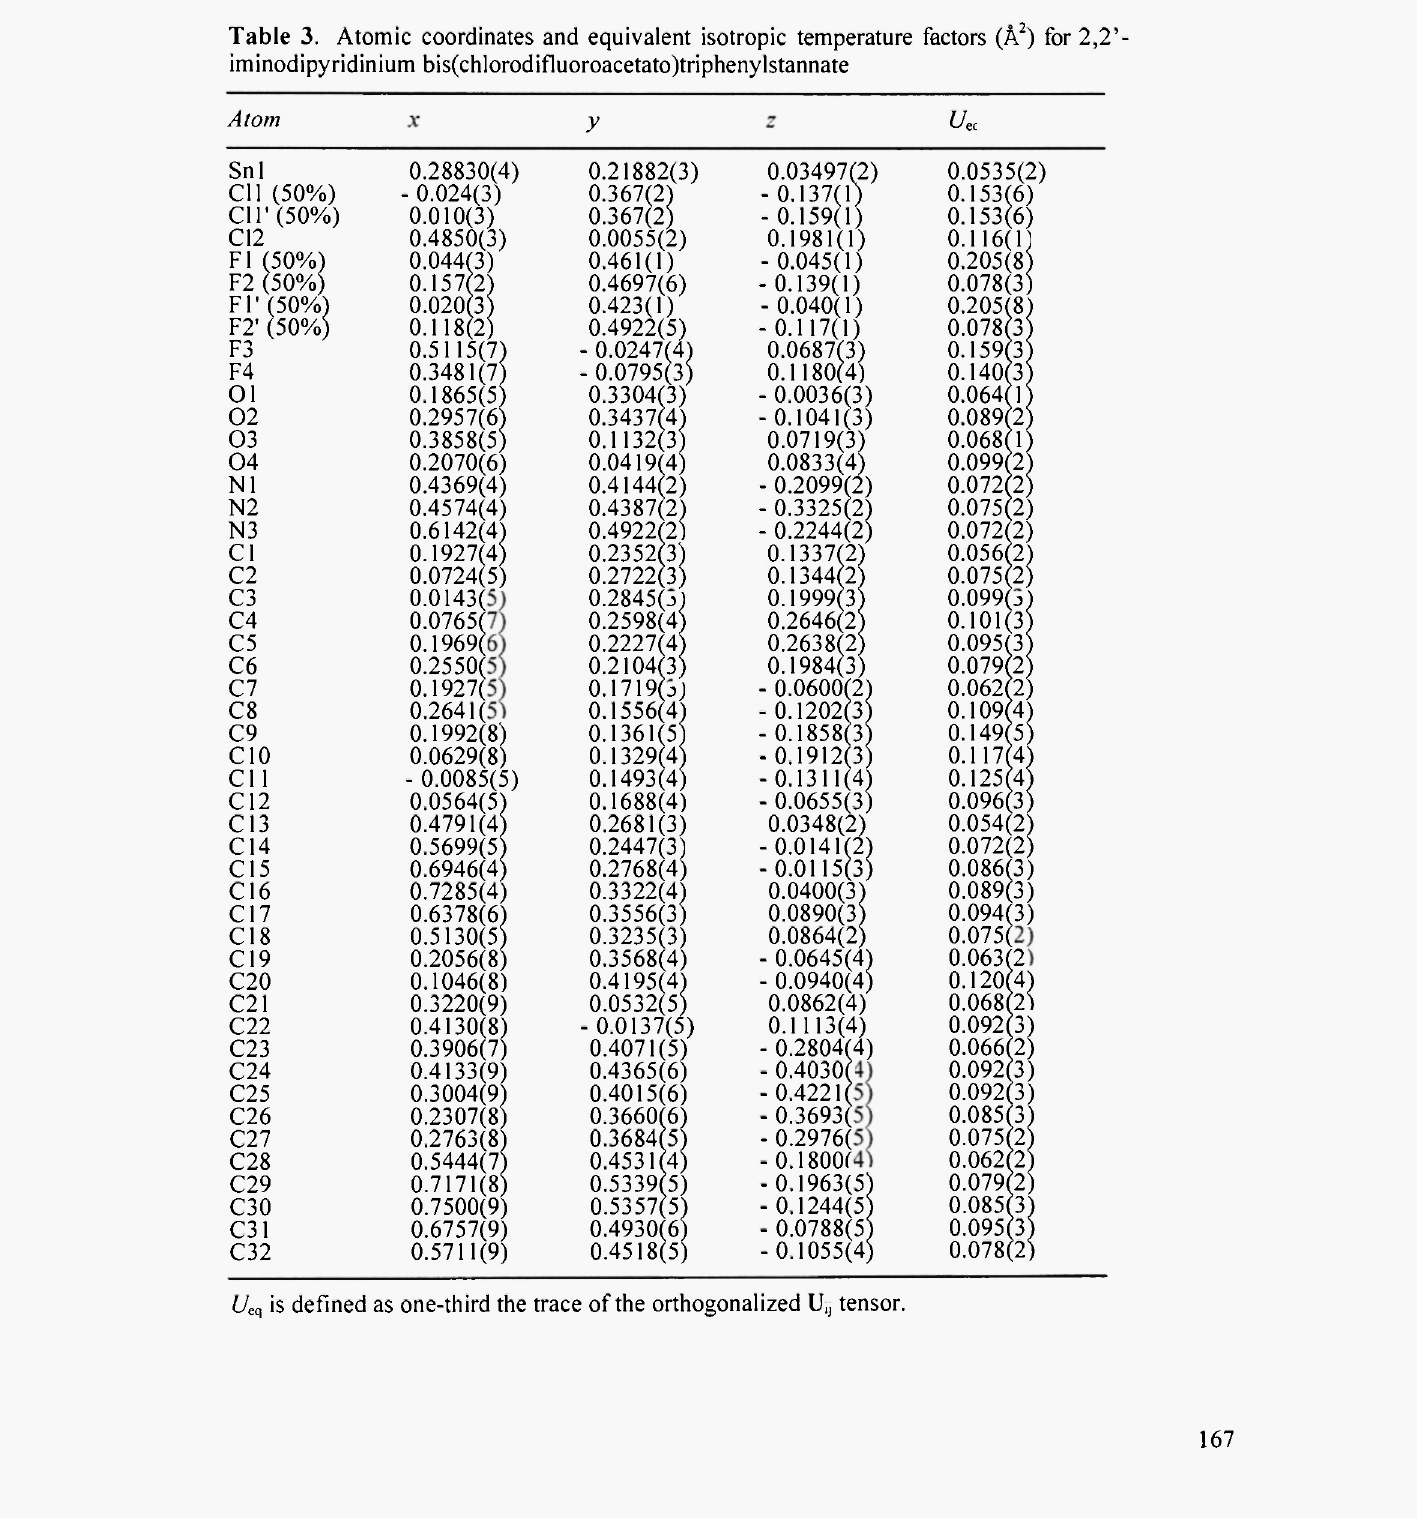
Table 3. Atomic coordinates and equivalent isotropic temperature factors (A 2 ) for